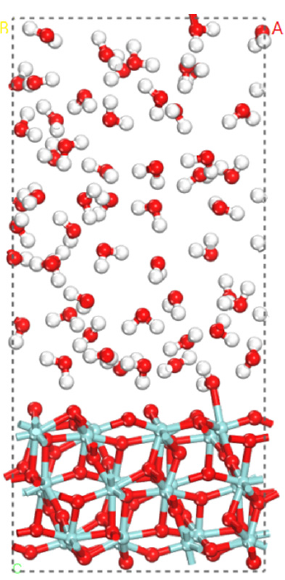
Figure 5. The three-layer model structure of the water–solid interface reactions of ZrO 2 .